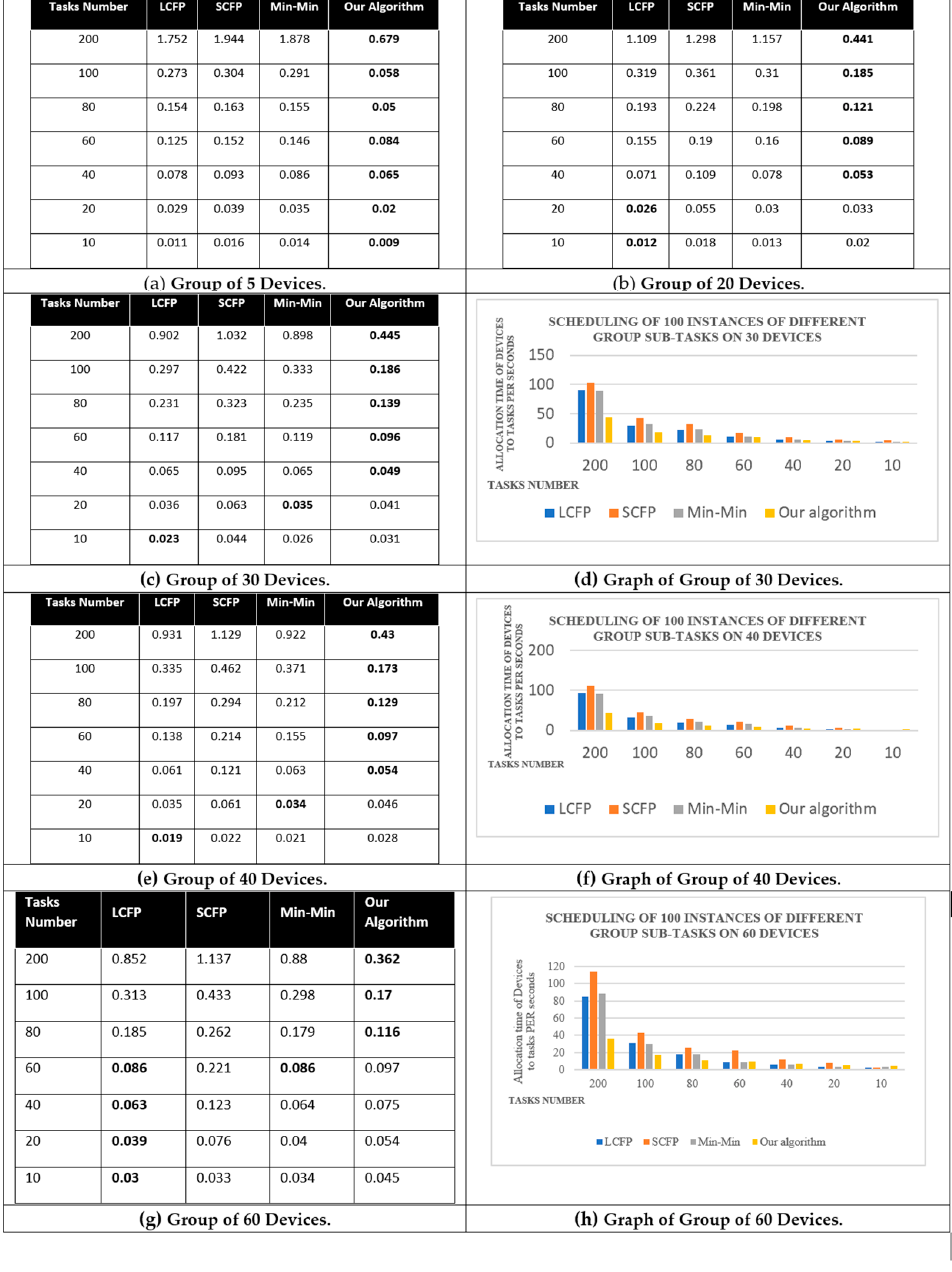
Figure 6. Performance of the algorithms with respect to their running times.